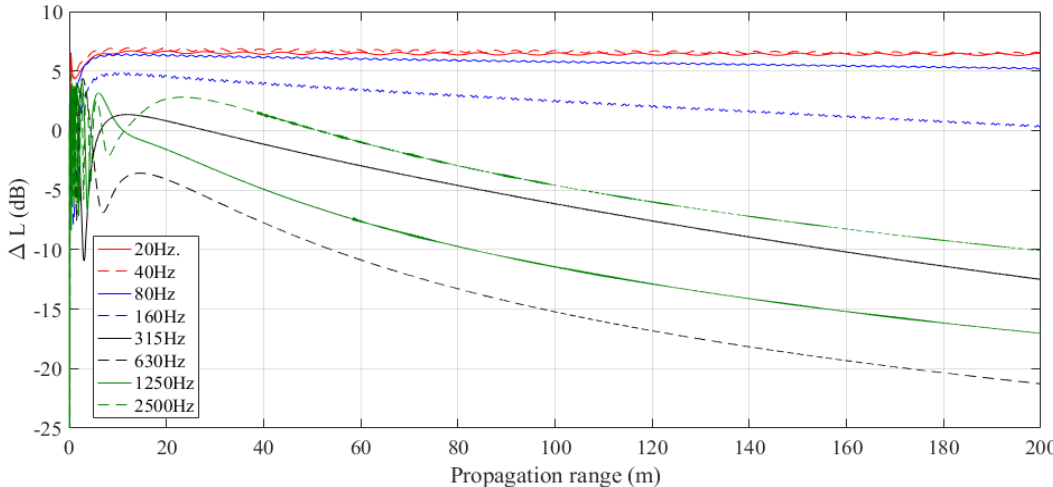
Figure 3. Sound transmission loss over 200 m at various frequencies (soft ground).